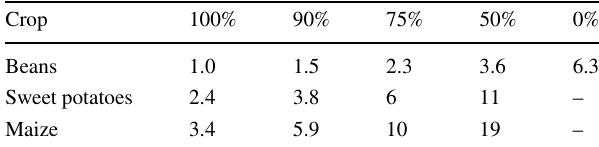
Table 2 A summary of descriptive statistics of mean soil salinity (EC e ) variation at various soil depths